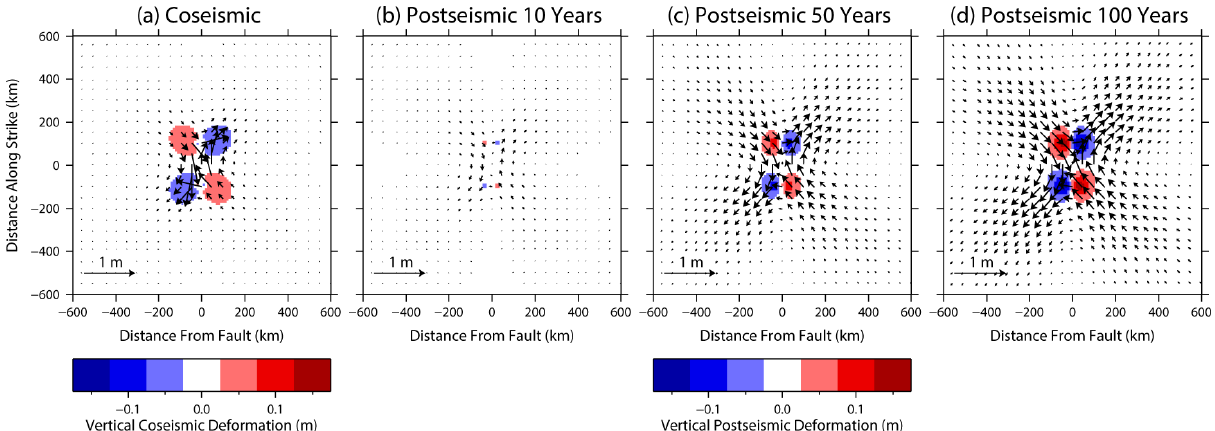
Figure B1. Model-predicted surface displacement in response to slip on a strike-slip fault. Background colours show vertical displacement and arrows show horizontal displacement for (a) coseismic displacement; (b–d) post-seismic deformation at 10, 50, and 100 years after fault slip,